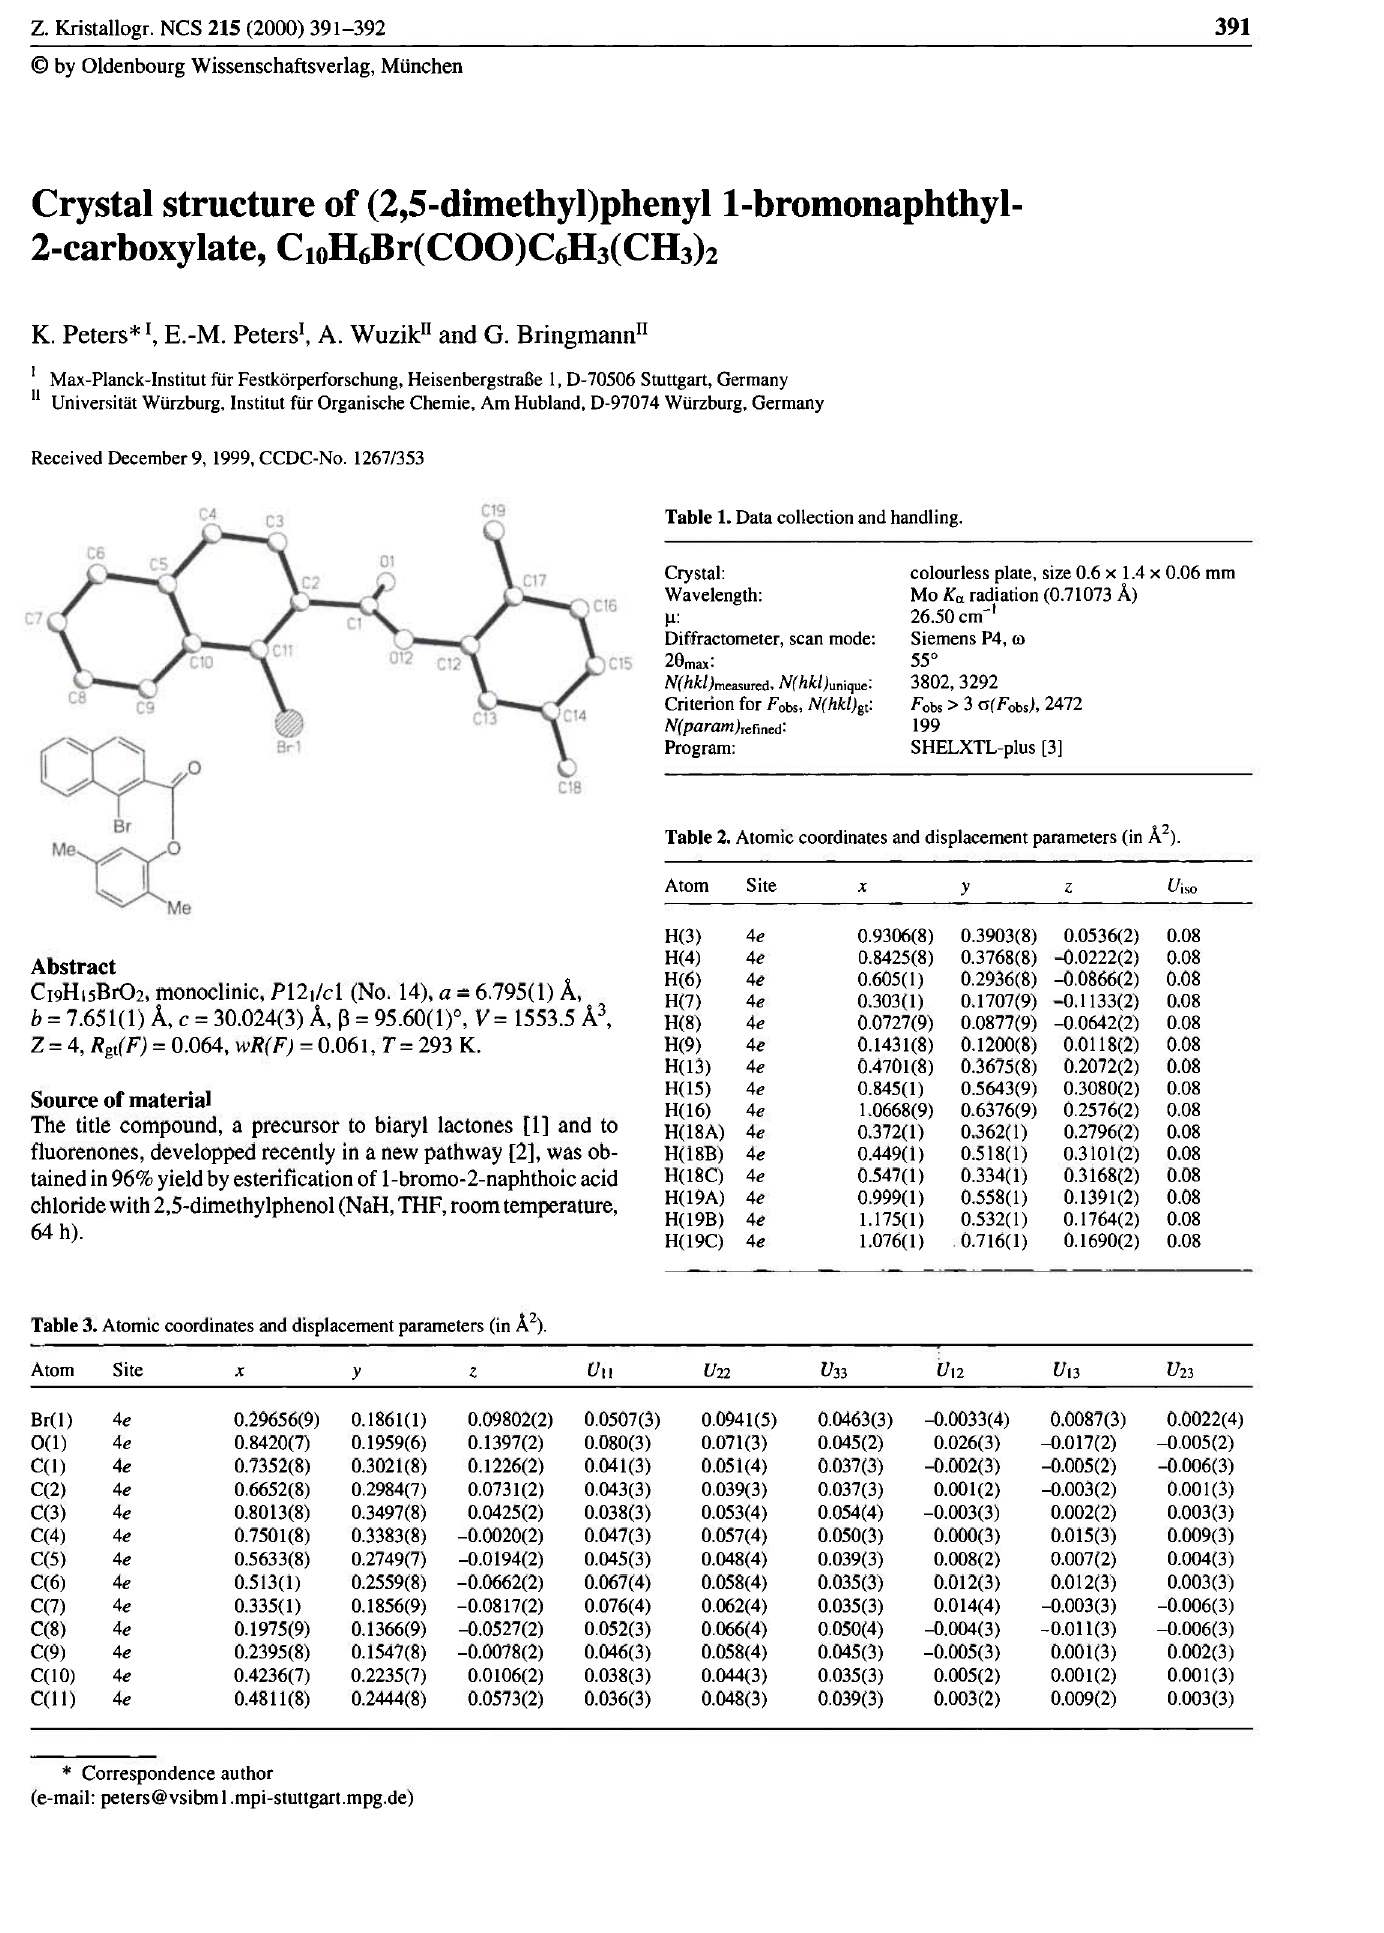
Table 1. Data collection and handling.